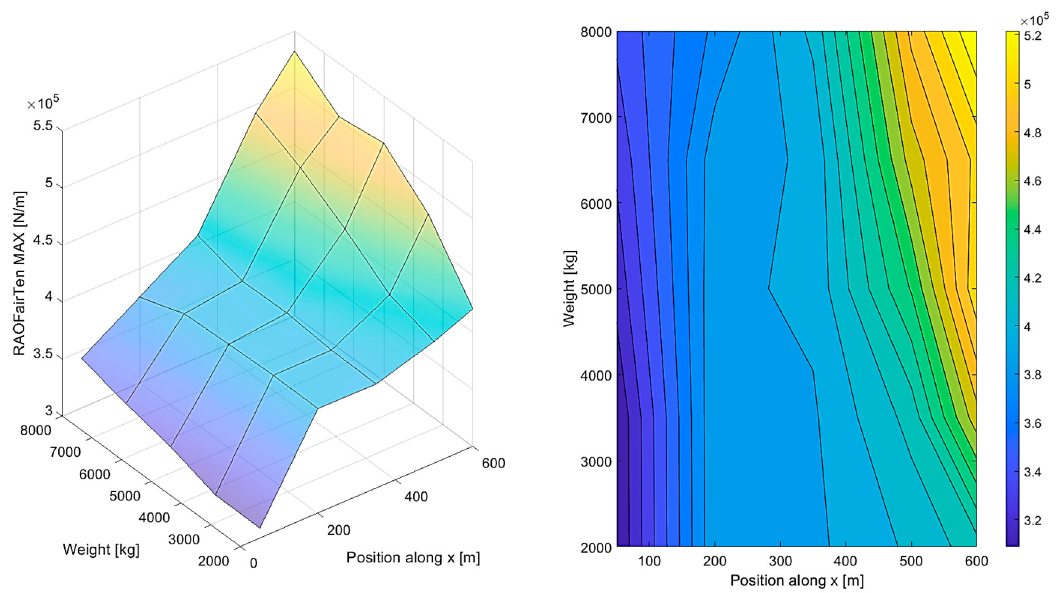
Figure 6. Peak of the Fairlead Tension RAO using 5 different positions and 5 different masses.